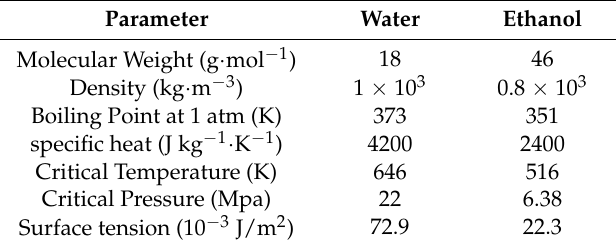
Table 3. Solvent properties of water and